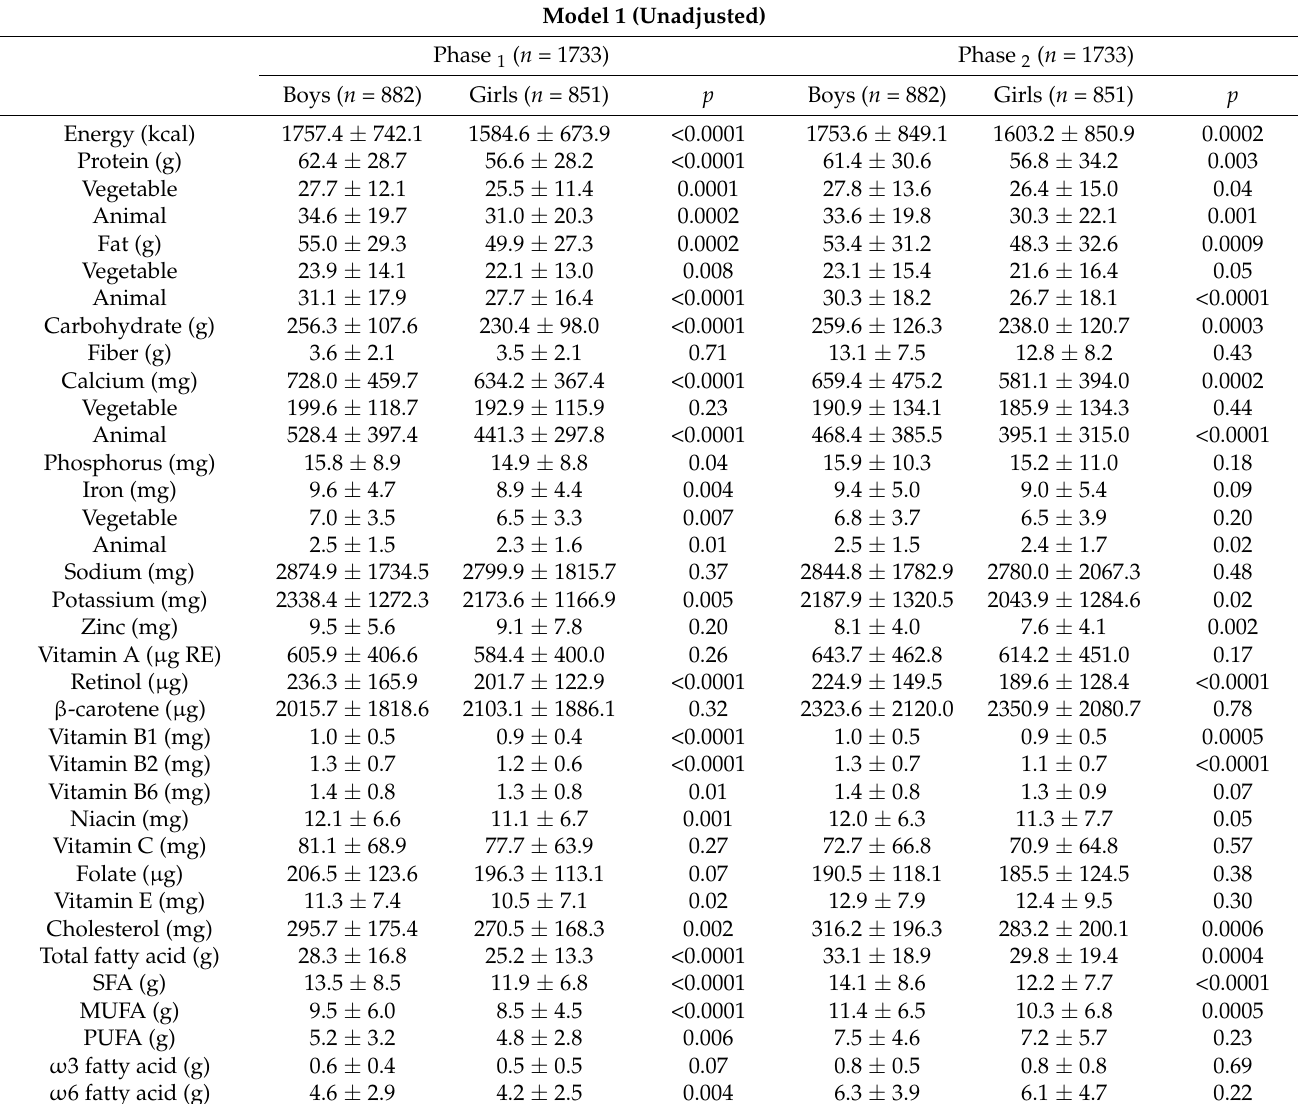
Table 2. Nutrient intake level according to the measurement time and